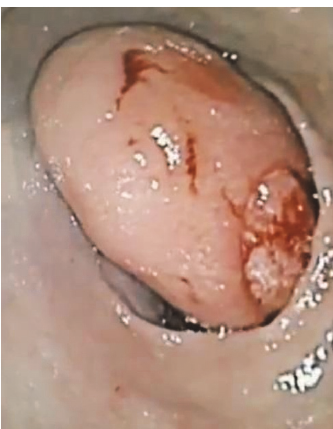
Figure 1: First endoscopy showing large gastric antral mass with friable ulcer at the top.